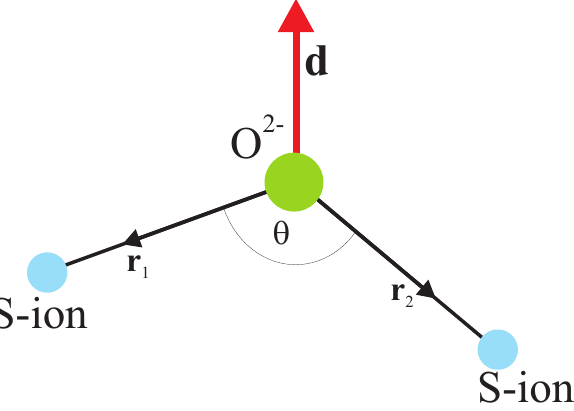
Figure 2. Superexchange geometry and the Dzyaloshinskii vector. Later on, the derivation had been generalized for the 3 d ions in a strong cubic crystal field (see, e.g., Refs.